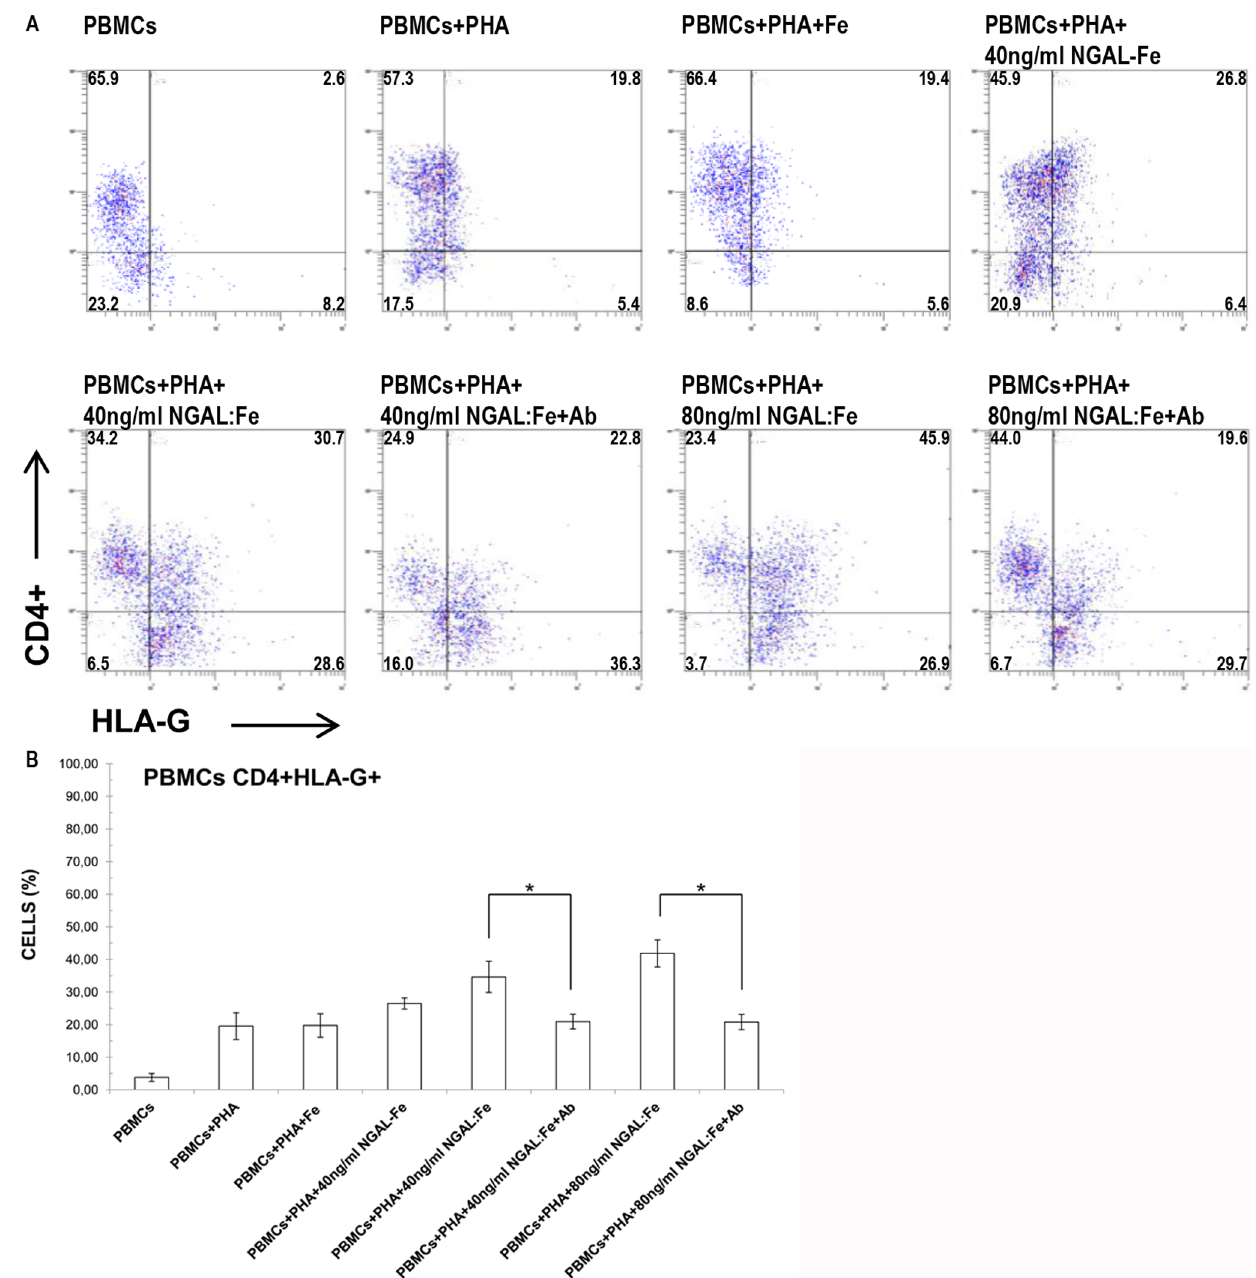
Figure 2. Effects of iron and NGAL neutralization on HLA-G expression in PHA-activated PBMCs. Flow cytometry analysis of HLA-G expression on CD4 + cells. Iron treatment (without NGAL) did not increase the percentage of HLA-G + cells. Treatment with the NGAL:enterobactin complex (without iron) reduced HLA-G expression in contrast to stimulation with NGAL:Enterobactin:Iron. Incubation with anti-NGAL antibody reduced the percentage of HLAG + cells. Data are representative of 8 independent experiments. The number in each quadrant represents the percentage of the total population. B) Data are expressed as percentages of CD4 + HLA-G + cells. Means 6 SD; n=8. * p , 0.05.